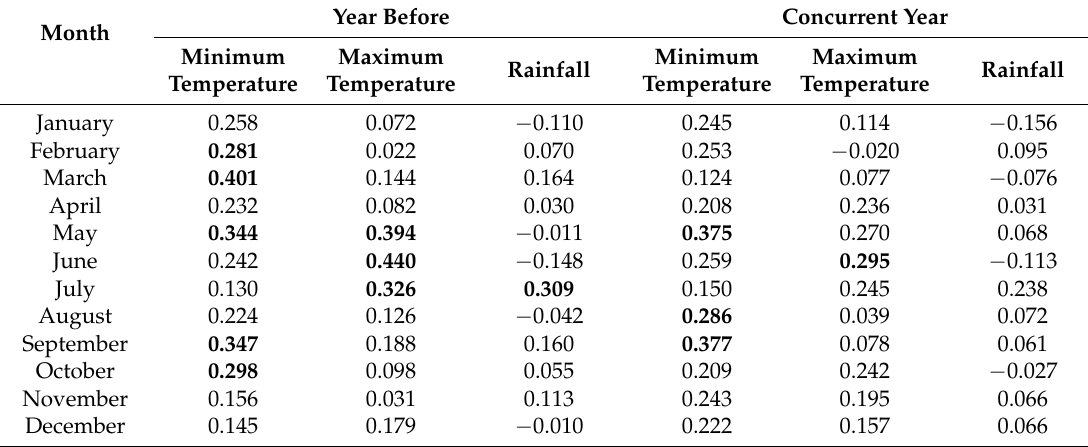
Table 4. Table of correlation between climatic variables and tea yield. (The correlation values significant at 5% significant level are bolded).